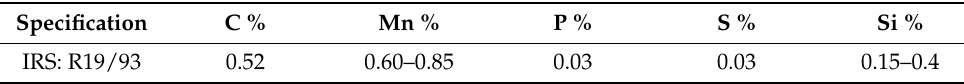
Table 1. Chemical components in the wheel [33].